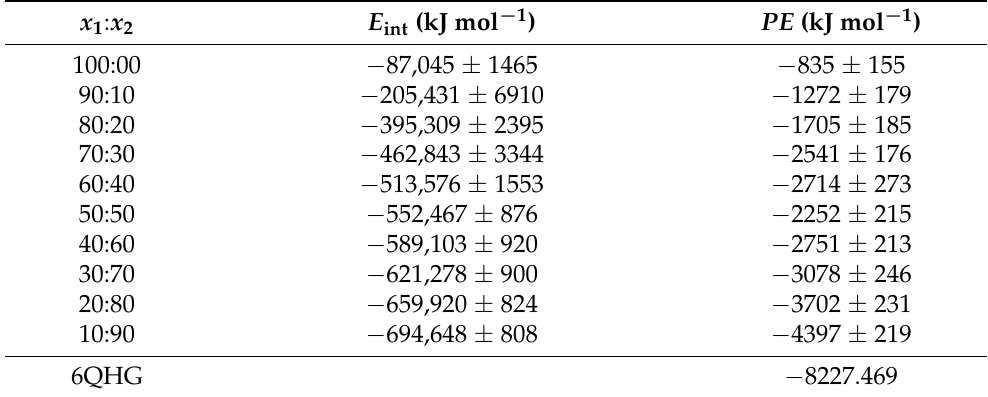
Table 1. Energetics evaluation at T = 298.15K: Interaction energy, E int and Potential energy PE of RVFV peptide in the